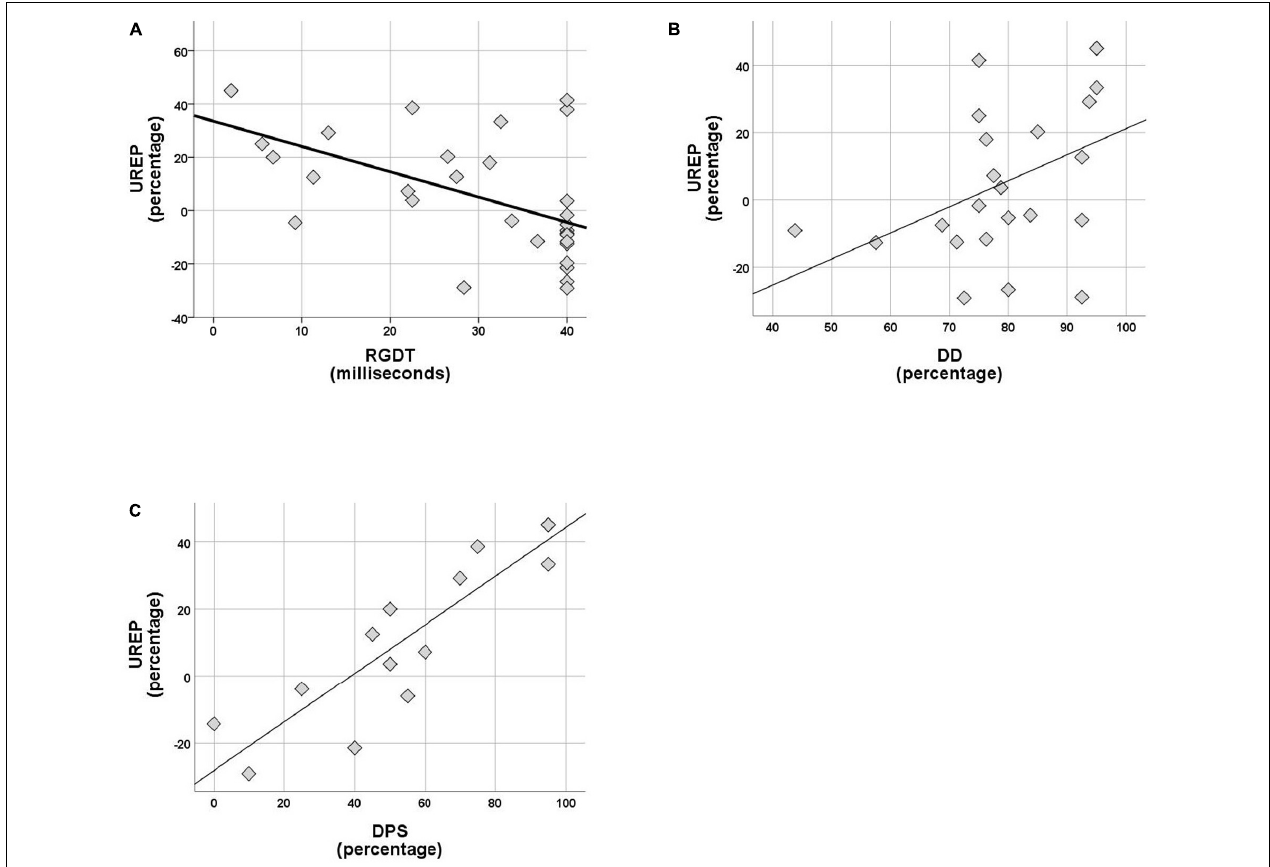
FIGURE 5 | (A–C) Scatterplots of UREP scores vs. RGDT, DD, and DPS respectively, for APD group. Correlations are r = –0.559, p = 0.001, r = 0.427, and r = 0.886 respectively. UREP, un-synchronized rhythm effect percentage; DD, dichotic digits; DPS, duration pattern